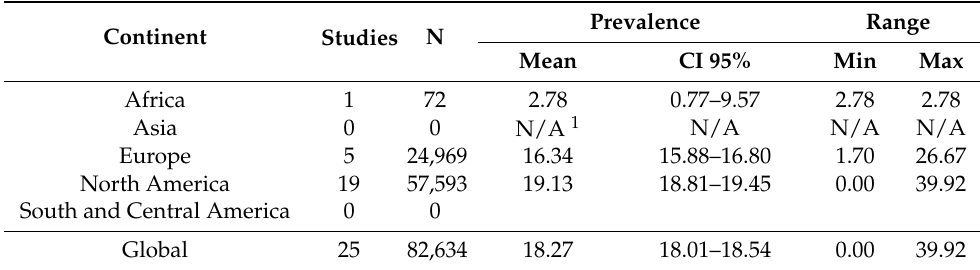
Table A1. Animal SLRV prevalence in each continent from 1981 to 1990.